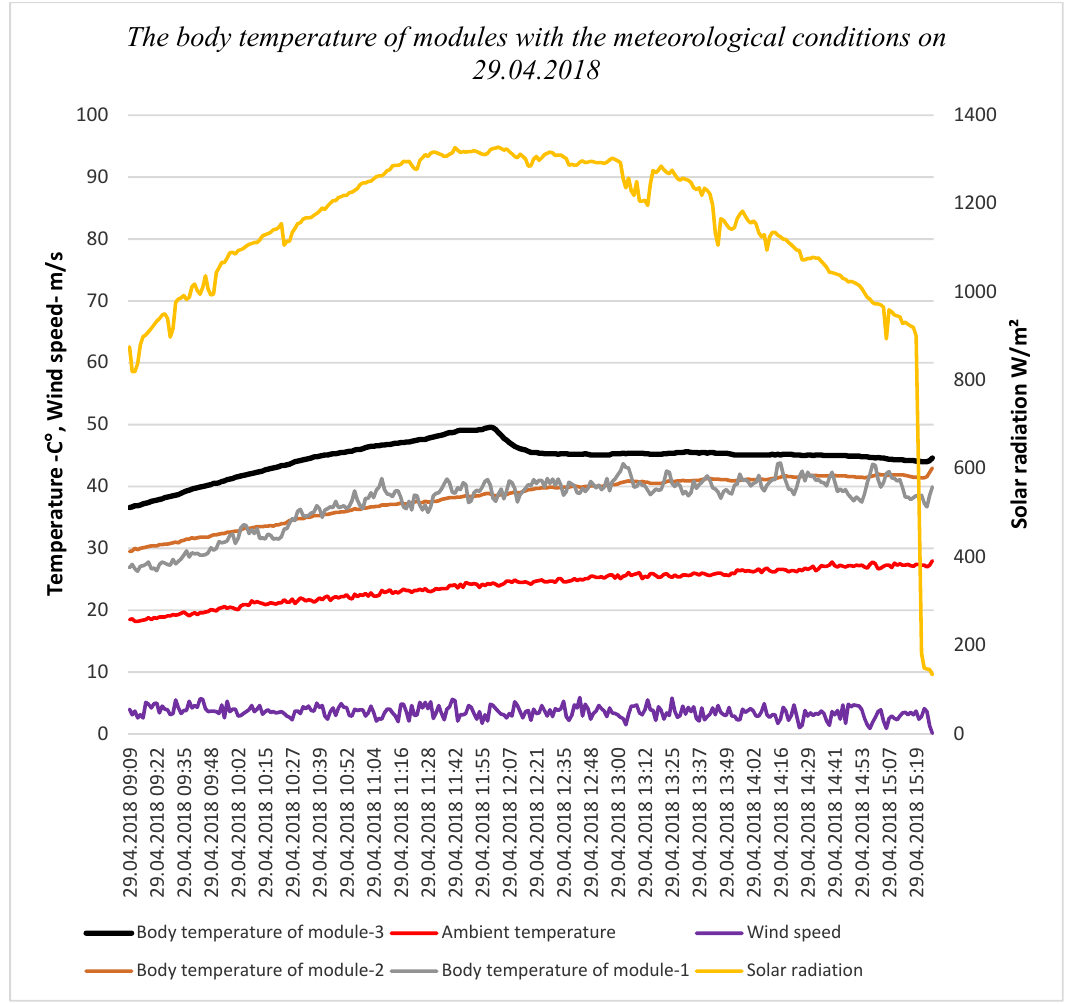
Figure 6. The body temperature of the modules with the meteorological conditions on 29.04.2018. The body temperature tendencies of the modules with meteorological conditions on 01.07.2018 are shown below in Figure 7. Cooling by water and air were initiated at 12:00 in the PV/T modules. The ambient air was clear and calm. Therefore, the wind speed was not recorded. The temperatures in module-2 and module-3 were close to each other but the temperature in module-1 was higher than the other modules.